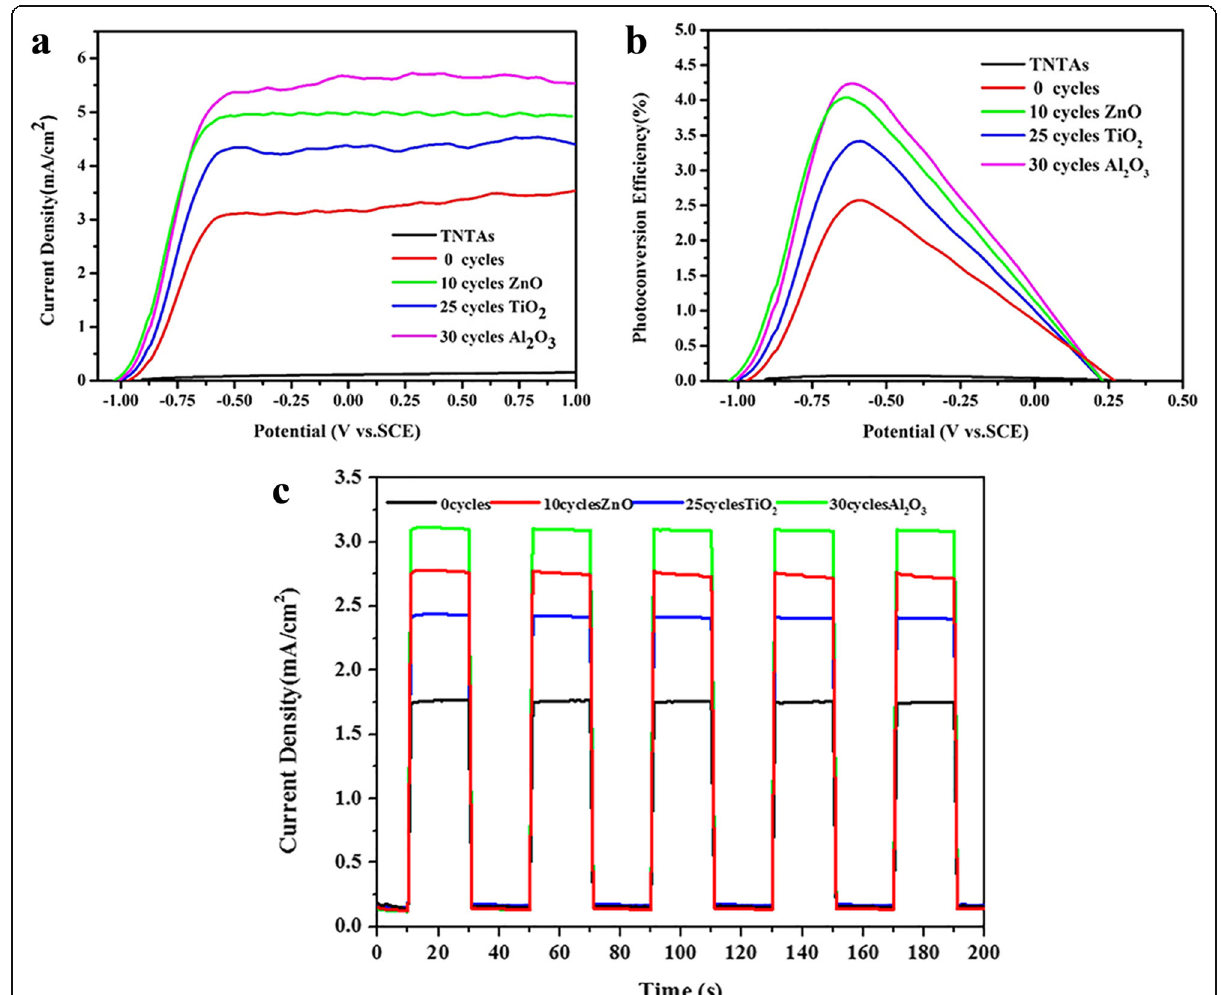
Fig. 6 PEC properties of the TNTAs/QDs, TNTAs/QDs/10 cycles ZnO, TNTAs/QDs/25 cycles TiO 2 , and TNTAs/QDs/30 cycles Al 2 O 3 electrodes with a surface area of 1 cm 2 . a LSV curves of the electrodes under simulated solar illumination. b Photoconversion efficiency derived from LSV curves. c Transient photoresponse under chopped light irradiation under a potential 0 V vs.